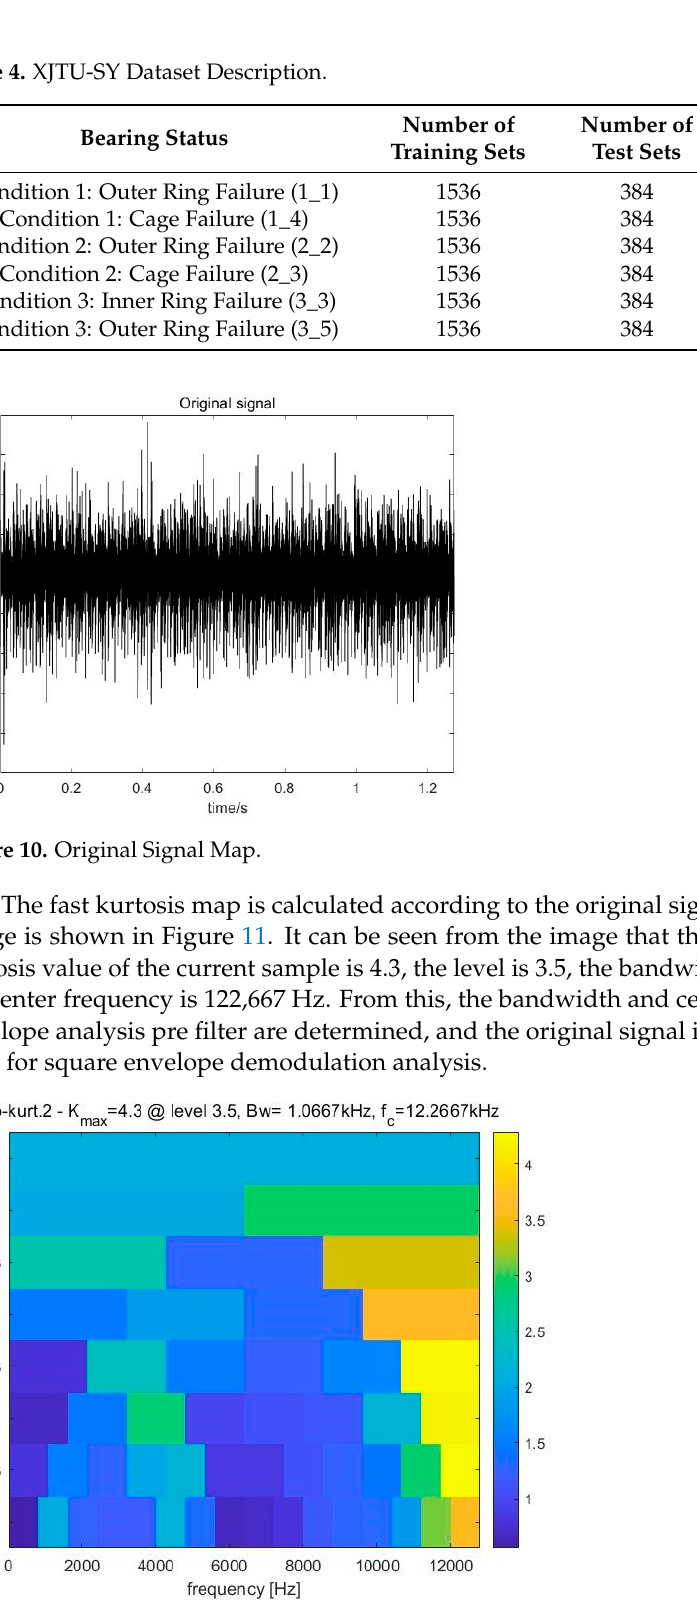
Figure 12. Fast Spectral Kurtosis Processing Results.